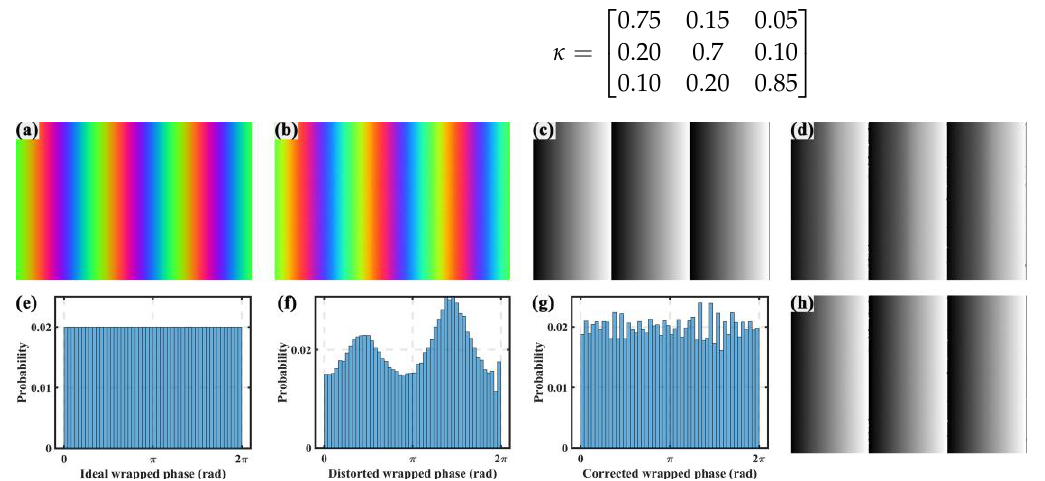
Figure 2. Simulated data: ( a ) ideal pattern; ( b ) distorted pattern; ( c ) ideal phase; ( d ) distorted phase; ( e ) ideal PPD; ( f ) distorted PPD; ( g ) adjusted PPD with M = 50; and ( h ) corrected phase.